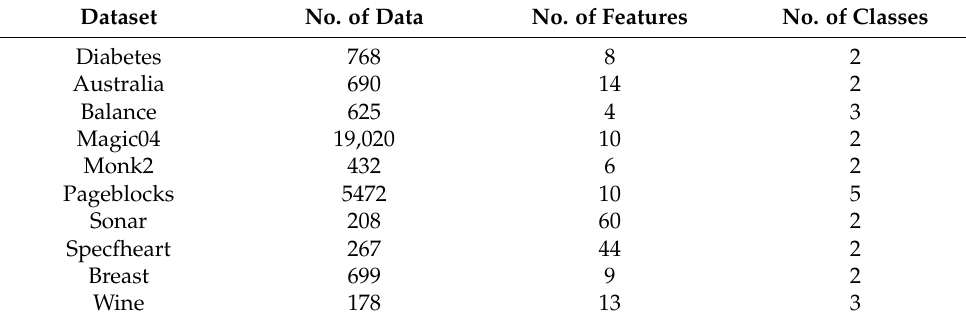
Table 7. Details of 10 classification datasets from UCI and